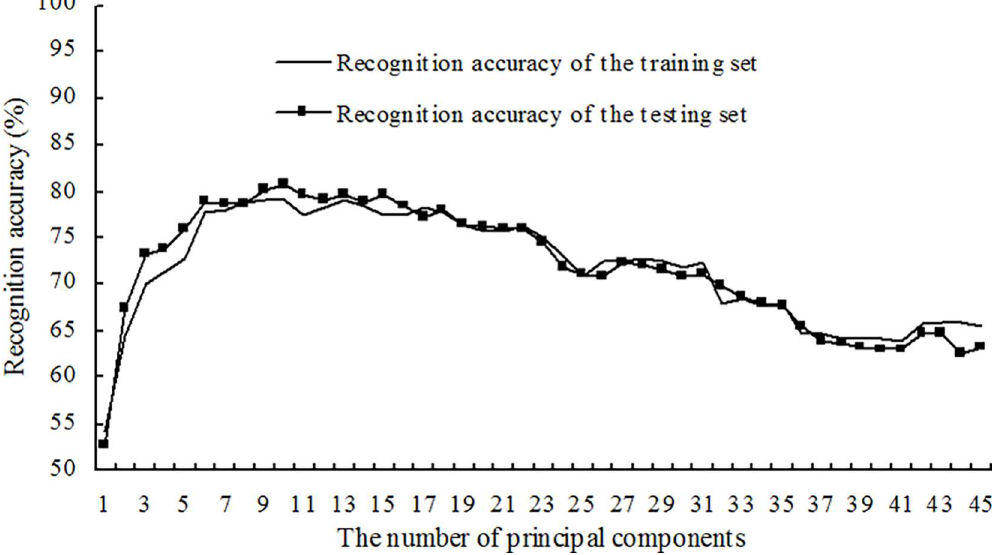
Fig 6. Recognition results for four alfalfa leaf diseasesusing semi-supervised models at a ratio of labeled to unlabeled samples of